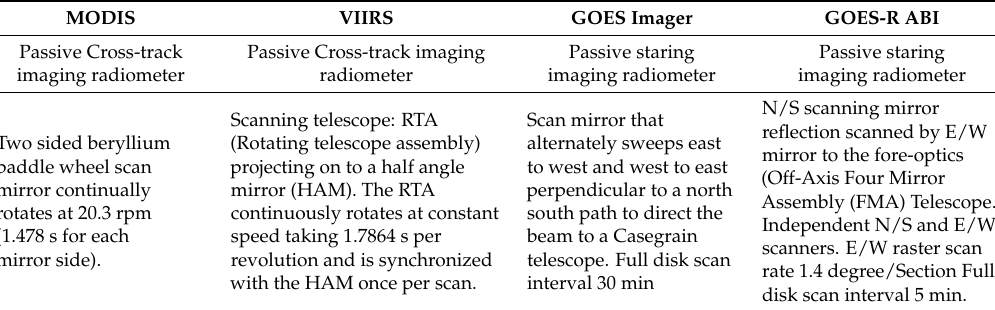
Table 4. Comparison of the radiometer optics.